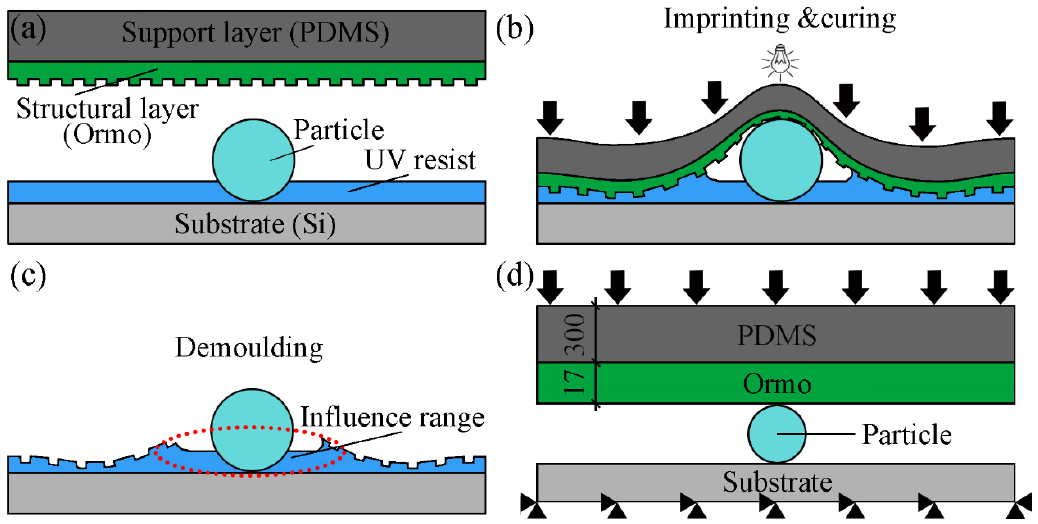
Figure 1. ( a – c ) schematic diagram of composite mould imprinting process encountered particles, ( d ) schematic diagram of geometric model and boundary condition in simulation.